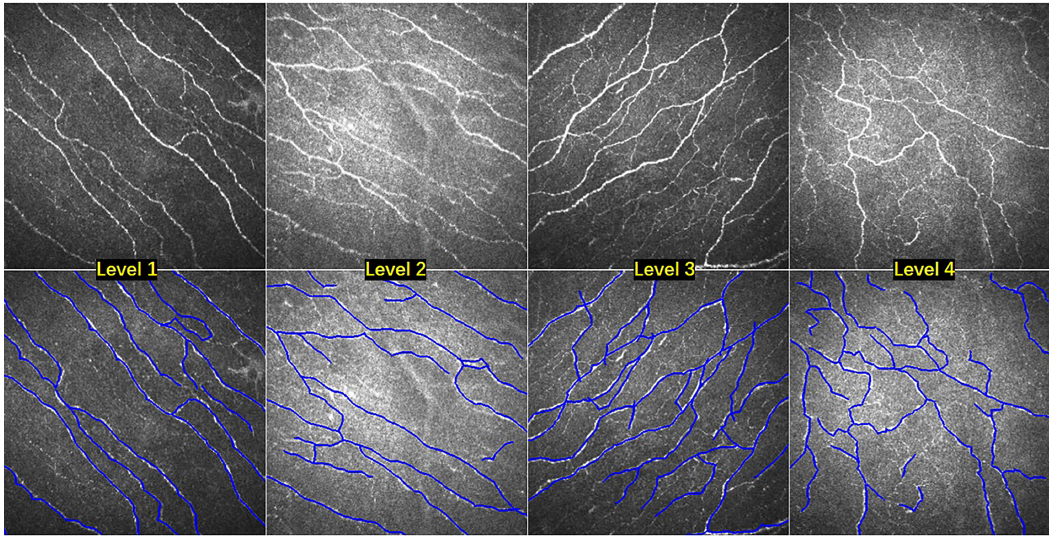
Figure 4. Nerve fiber images with four tortuosity levels, and their manual